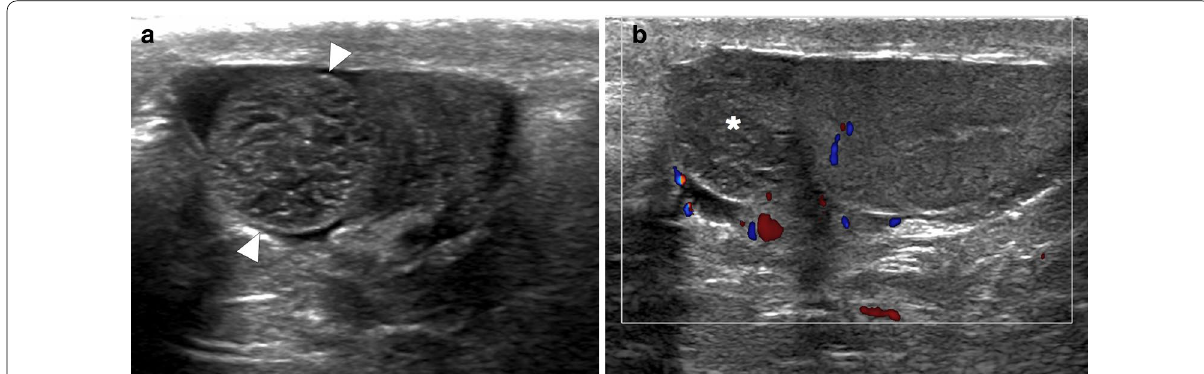
Fig. 21 Torsion of the appendix testis. A 9-year-old boy who presented to ER with left-sided scrotal pain which started 3 days before presentation. Physical examination revealed left testicular tenderness and a small, firm scrotal mass. a Gray scale US image shows a round mildly heterogeneous solid-appearing extratesticular lesion adjacent to the upper pole of left testis (arrowheads). Minimal hydrocele and scrotal wall thickening were also noticed on US. b Color flow Doppler US shows the absence of vascularity within the lesion (asterisk). As clinical history was more suggestive for torsion of the appendix testis, the patient was placed on supportive treatment. He responded well to treatment, and his symptoms completely resolved within a week